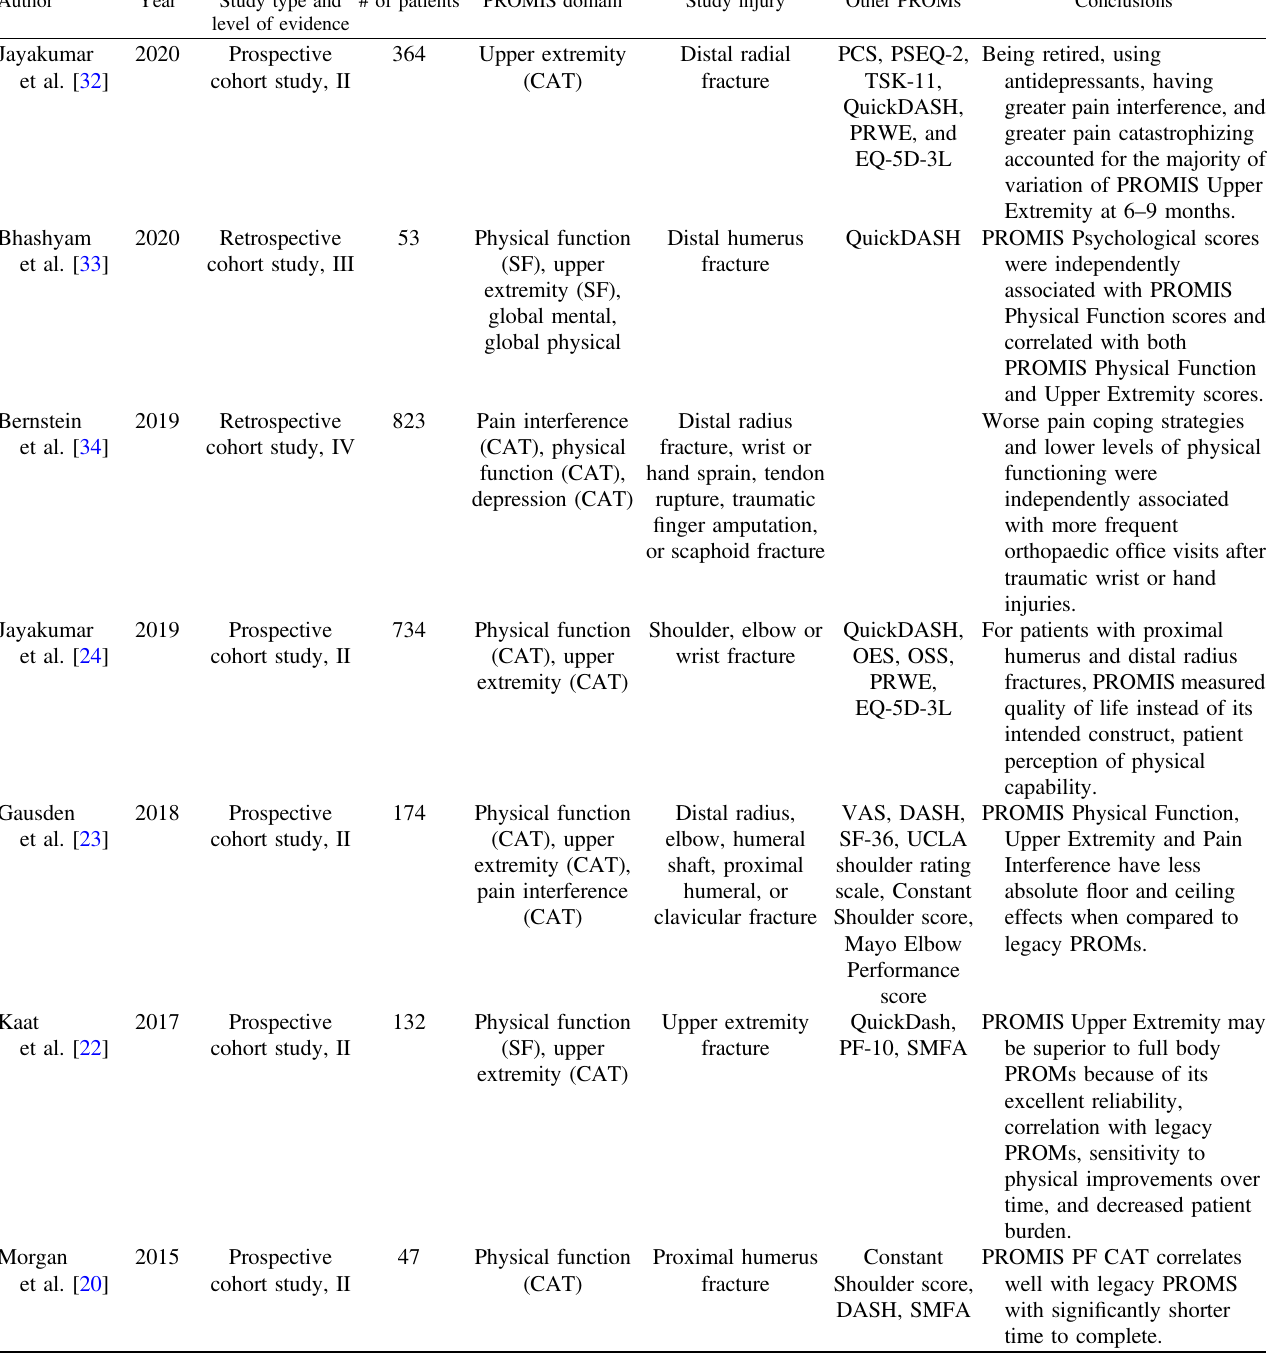
Table 1. PROMIS and upper extremity